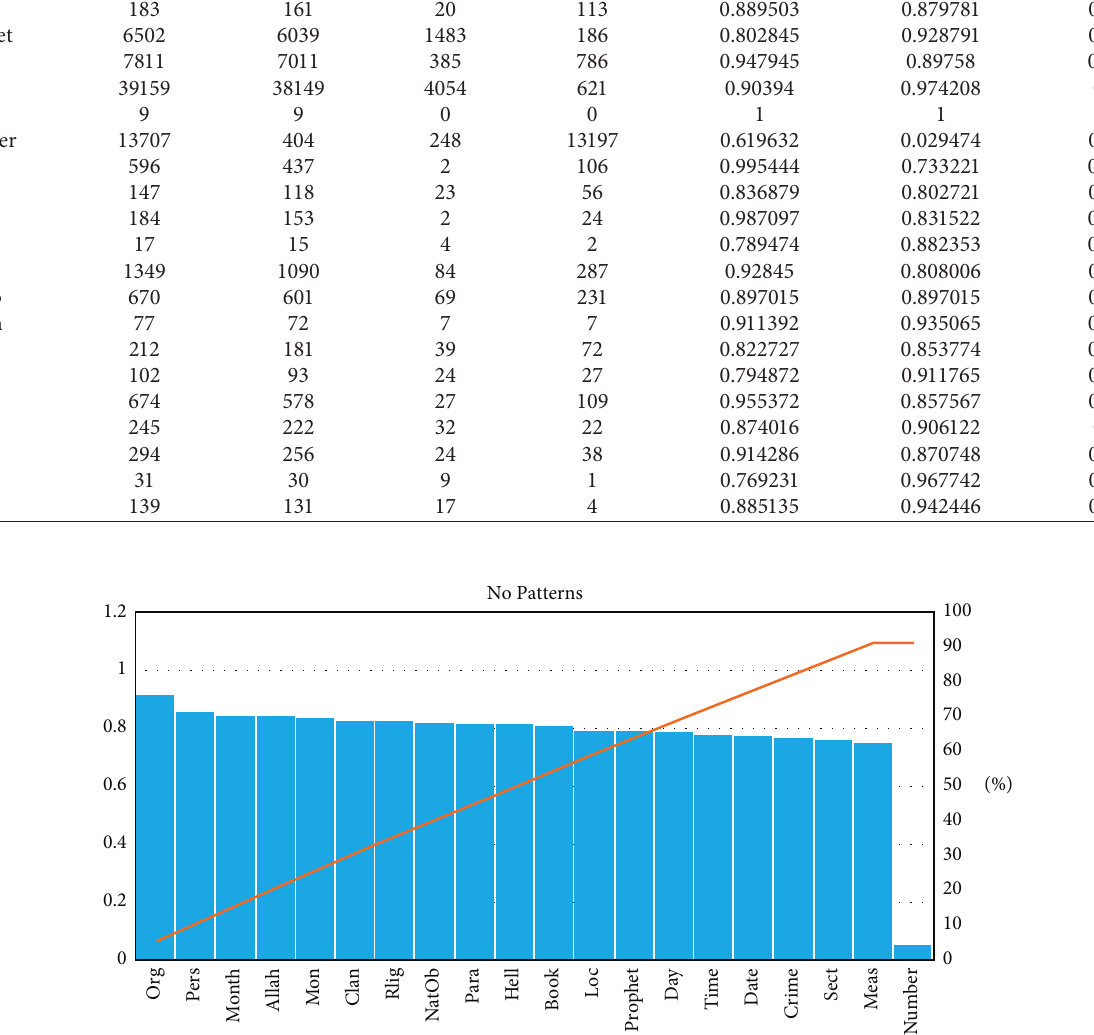
Figure 8: Results of not using